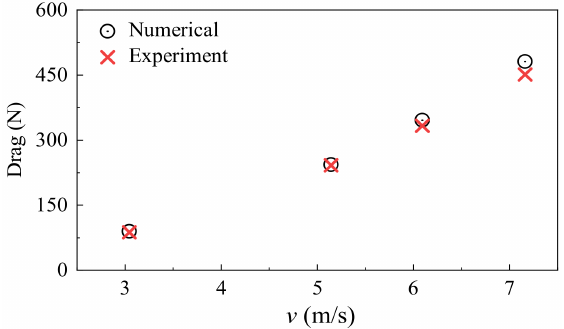
Figure 4. Comparison of the simulated results and experimental results